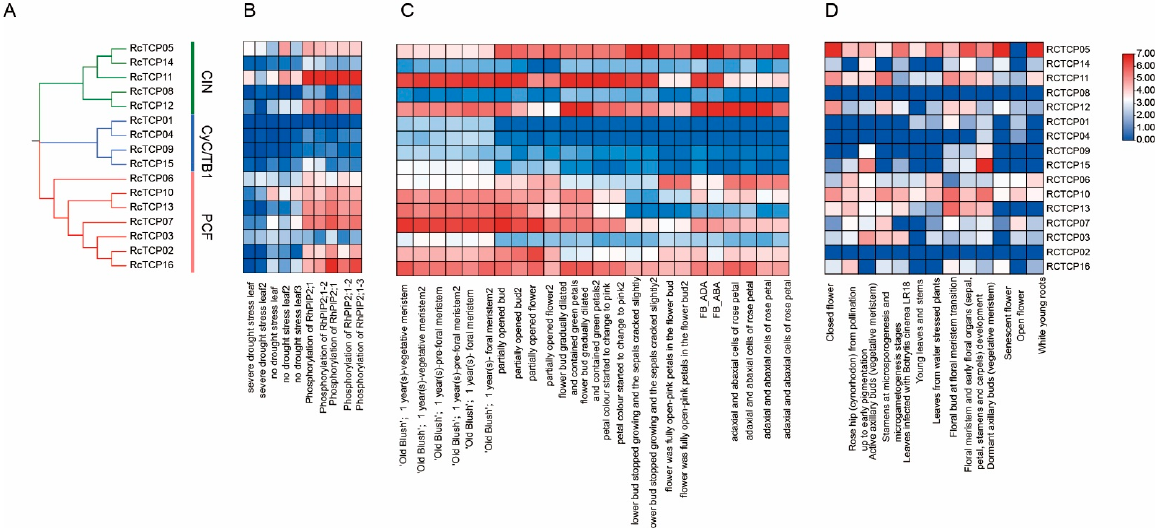
Figure 6. The gene expression pattern of RcTCP genes in different tissues and developmental stages. ( A ) Phylogenetic tree of 16 R. chinensis TCP genes. ( B ) Use TBtools software to take the log (log 2) of the FPKM value to convert the expression value for normalization. ( C ) RcTCP genes expression of leaves and aquaporin RrhPIP2;1 with drought stress. ( D ) RcTCP genes expression in floral organs.